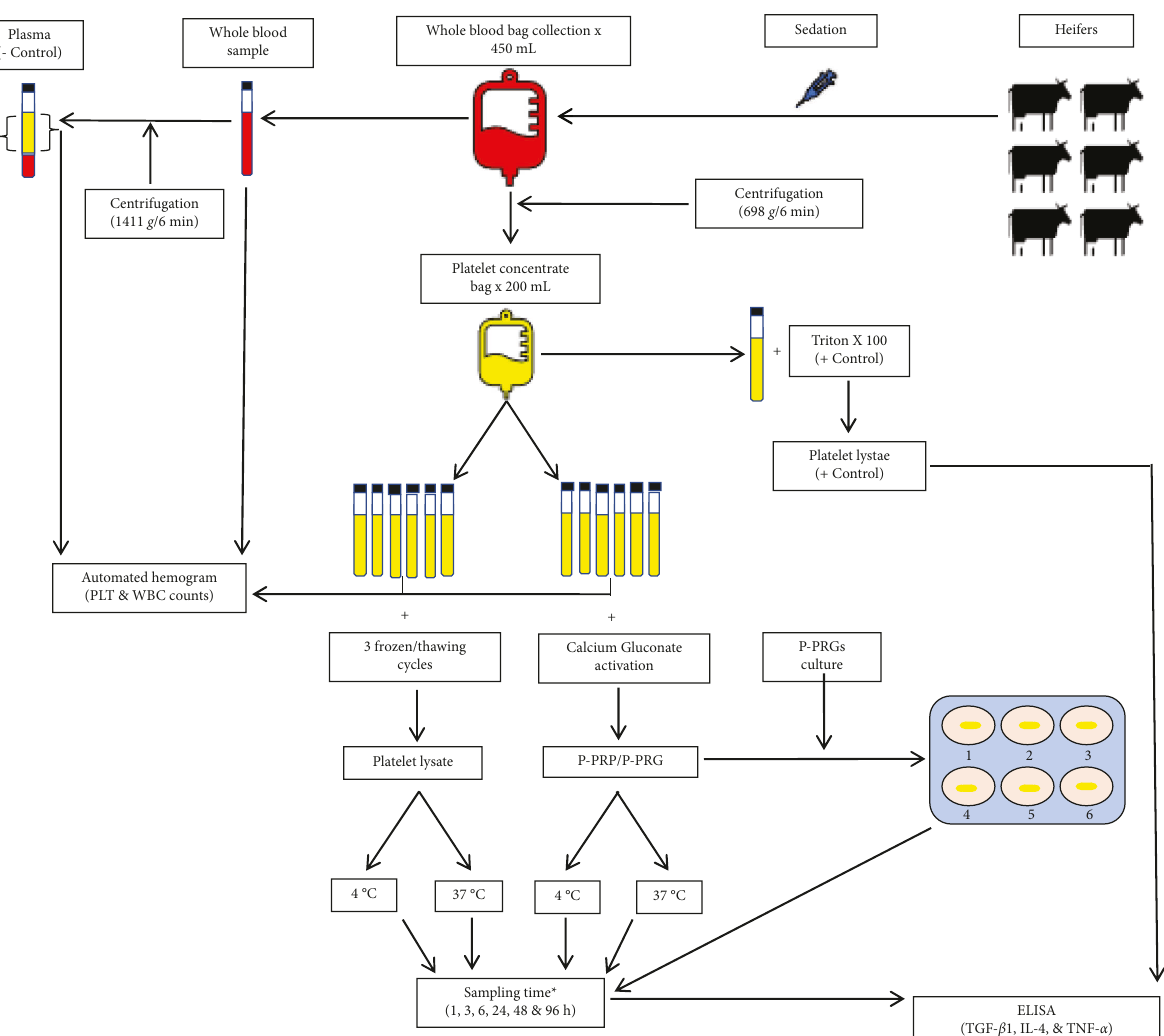
Figure 1: Study’s design. IL-4, interleukin 4; PLT, platelet; P-PRP, pure platelet-rich plasma; P-PRG, pure platelet-rich gel; WBC, white blood cell; TGF-b 1 , transforming growth factor beta 1; TNF- α , tumor necrosis factor alpha. ∗ P-PRP and platelet lysates induced by temperature were sampled at 3 and 96